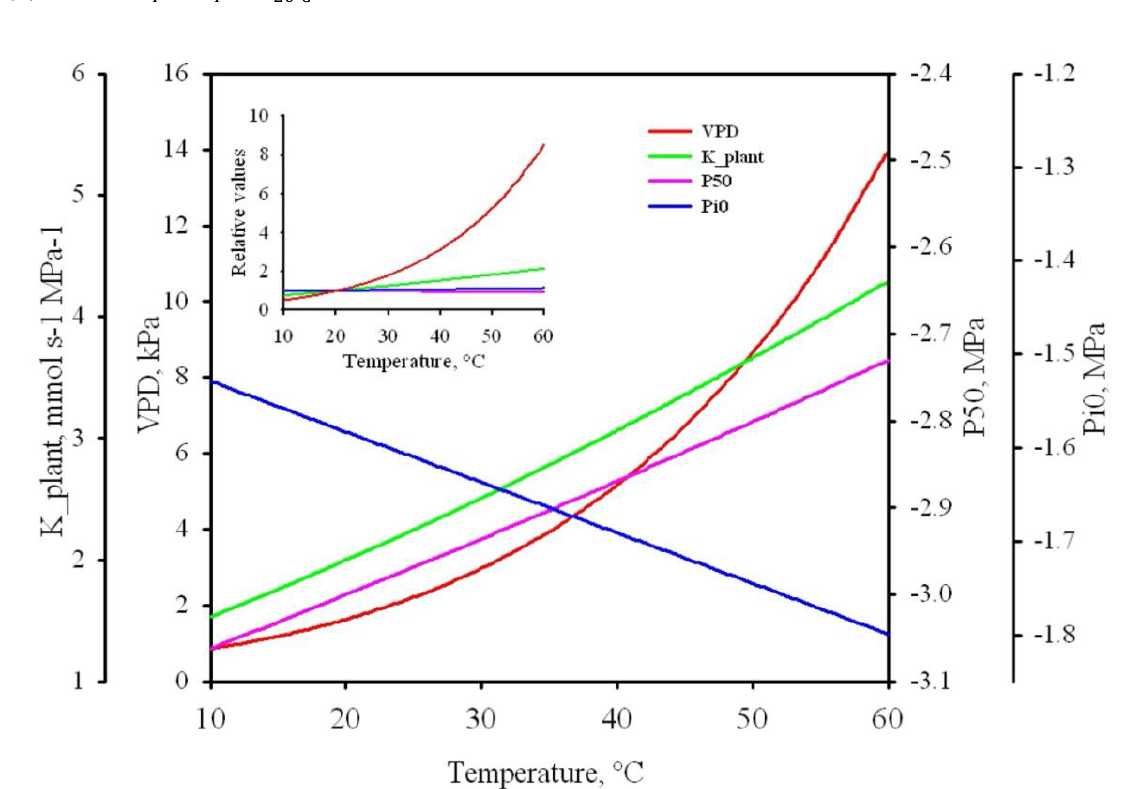
Figure 1: Theoretical effects of temperature on air VPD (red), plant hydraulic conductance Kplant (green), xylem vulnerability to cavitation P50 (pink) and osmotic potential Pi0 (blue). The relative variations of these parameters are shown in the